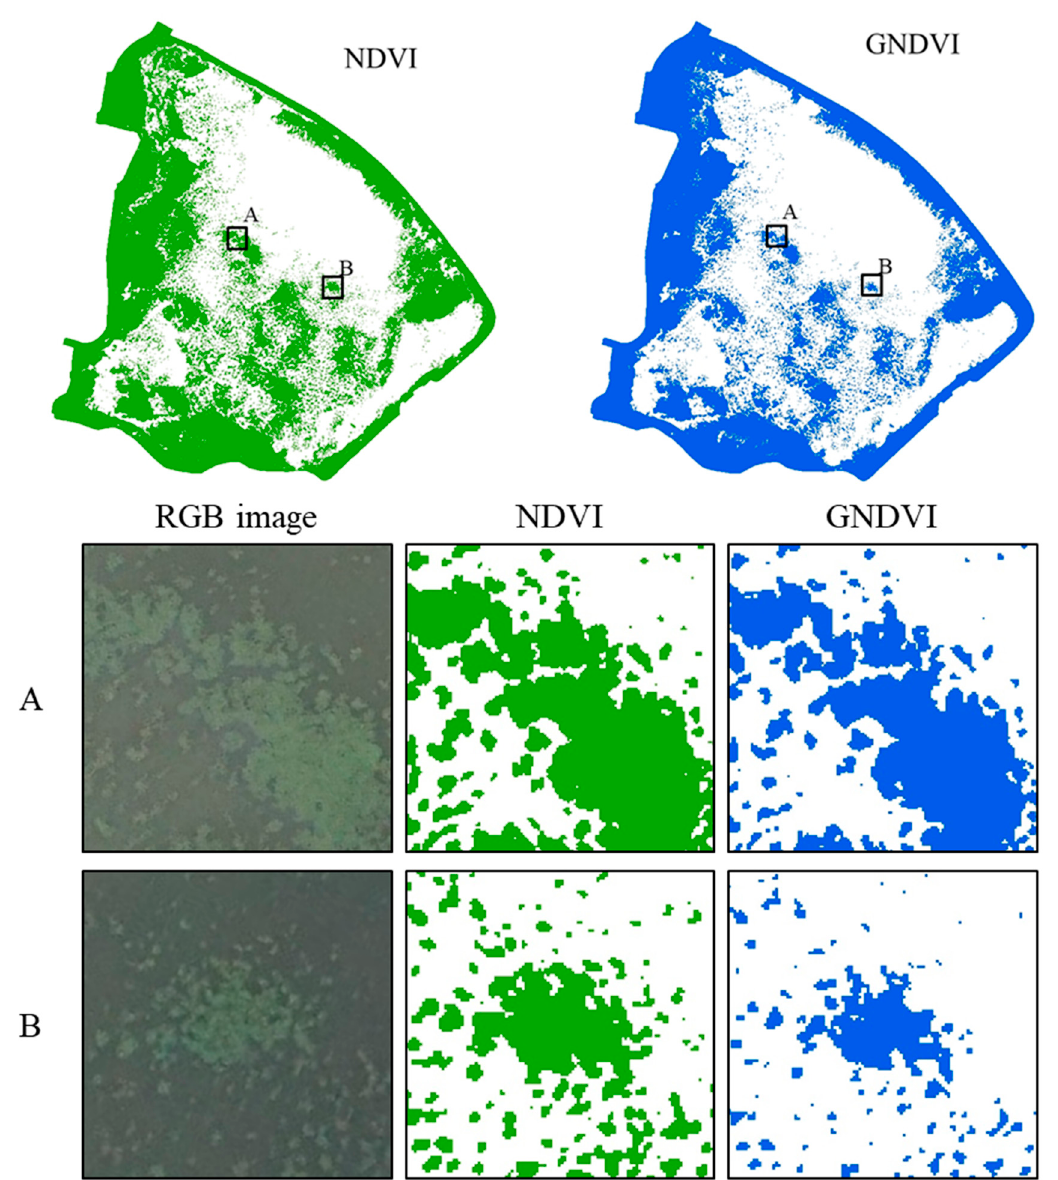
Figure 10. Extracted habitats of aquatic plants using the NDVI and GNDVI on June 25.